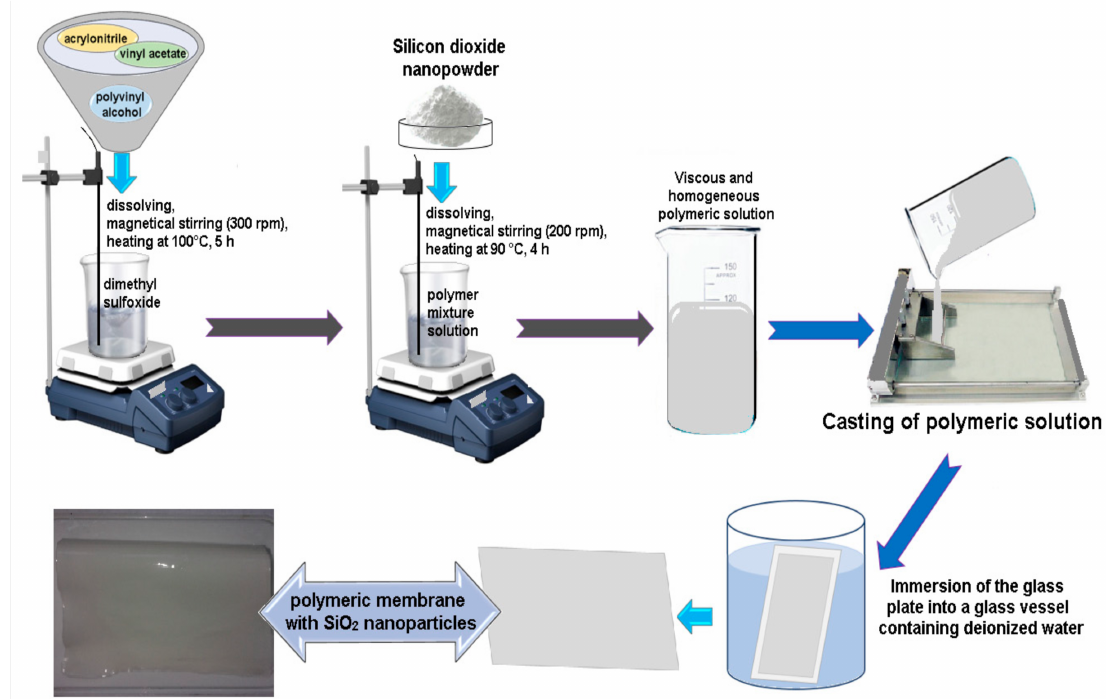
Figure 1. Schematic representation of the preparation polymeric membrane with SiO 2